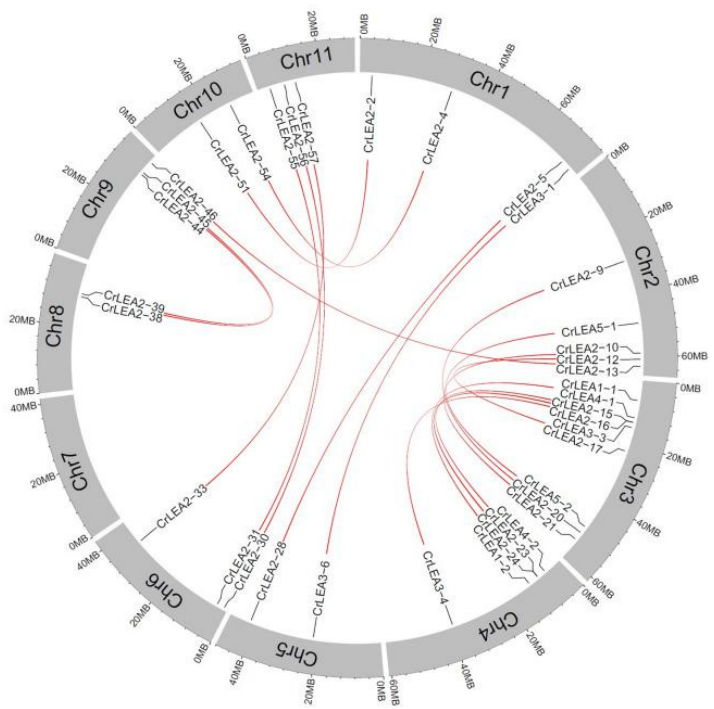
Figure 4. Segmental duplication of CrLEA/CrASR genes in C. rosea genome. Table 2. Ka/Ks analysis and duplicated date calculation for CrLEA genes.